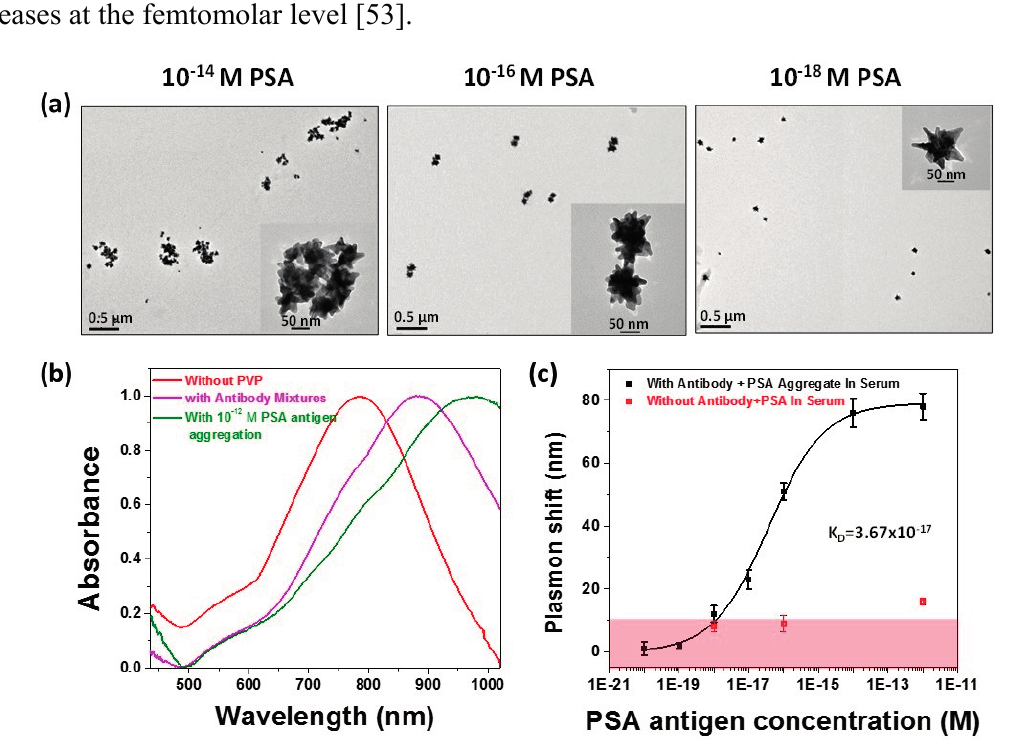
Figure 2. Biosensing using an aggregation assay with PSA protein in serum. Transmission electron microscopy data show a systematic trend of increasing nanostar aggregation with increasing concentrations of PSA, which gives rise to large shifts in the LSPR frequency, ( a ). Raw UV-Vis spectra of the treated nanostars, mixture of antibody-coated nanostars without PSA, and a saturating concentration of PSA revealing shifts as large as 180 nm, ( b ). The binding curve of PSA induced aggregation of antibody-coated nanostars, ( c ) The pink region depicts non-specific binding measured by mixing different concentrations of PSA with nanostars containing no antibody. The binding constant obtained from fitting the data to a single-site model indicates extremely tight binding and a limit of detection of 10 − 18 M PSA